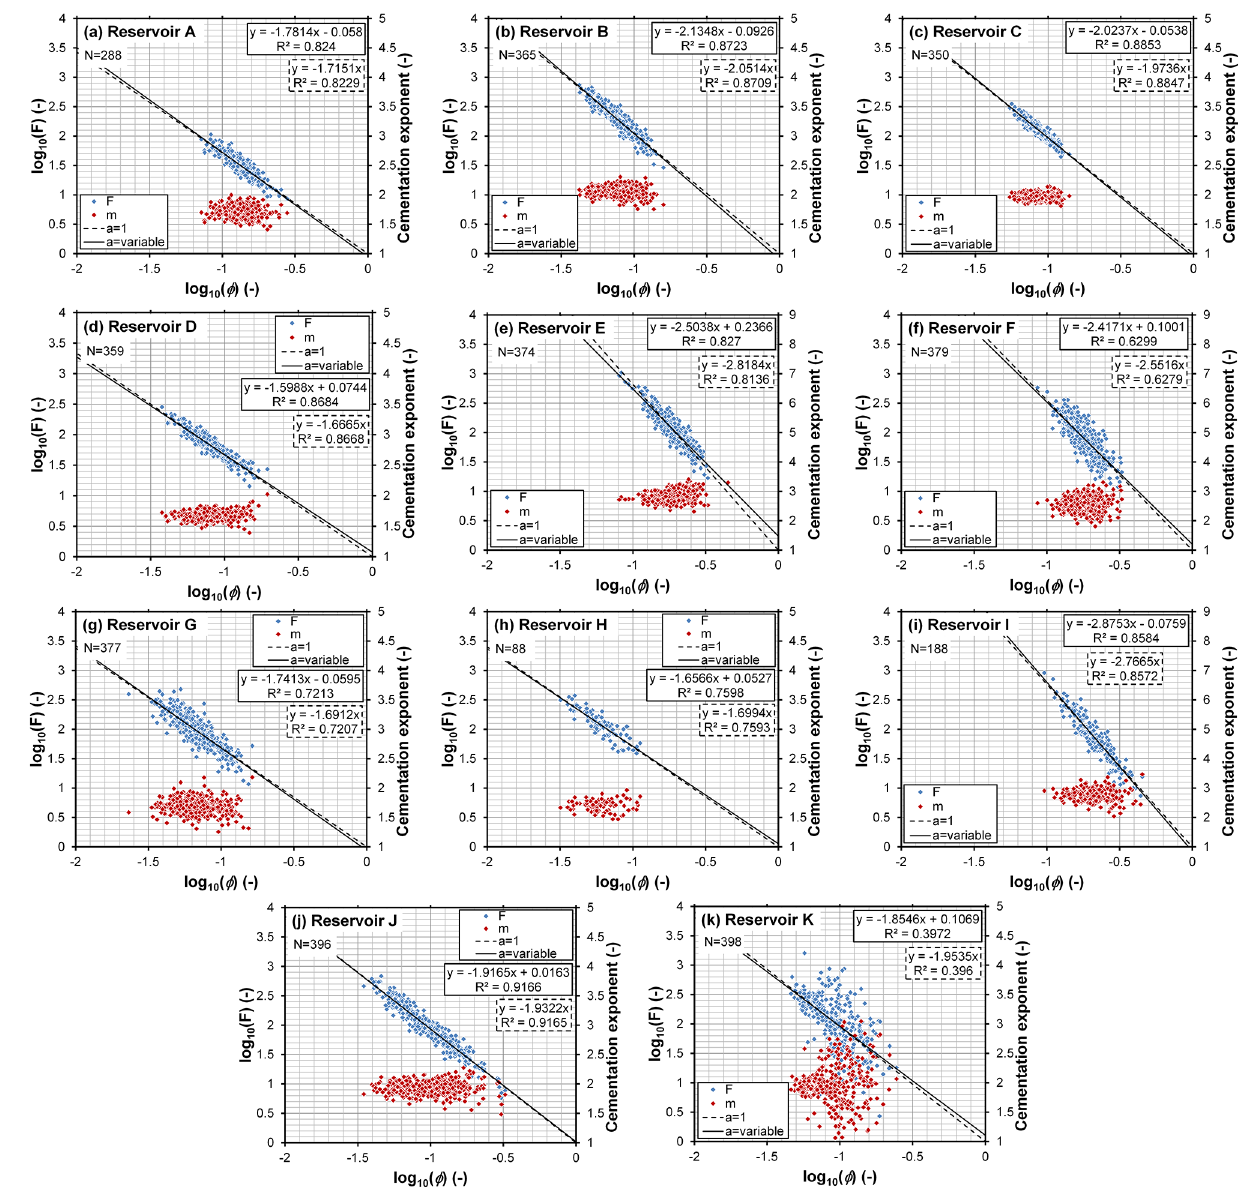
Figure 1. Formation factor and cementation exponent of the fully saturated rock sample as a function of porosity for 3562 core plugs drawn from the producing intervals of 11 clean sandstone and carbonate reservoirs. Blue symbols represent the formation factor for individual core plugs calculated as F = ρ o /ρ f and red symbols represent cementation exponents for individual core plugs calculated with Eq. (3). The solid line is the best fit to the Winsauer et al. (1952) variant of the first Archie’s law (Eq. 2), while the dashed line is the best fit to the original first Archie’s law (Eq. 1), each with adjusted R 2